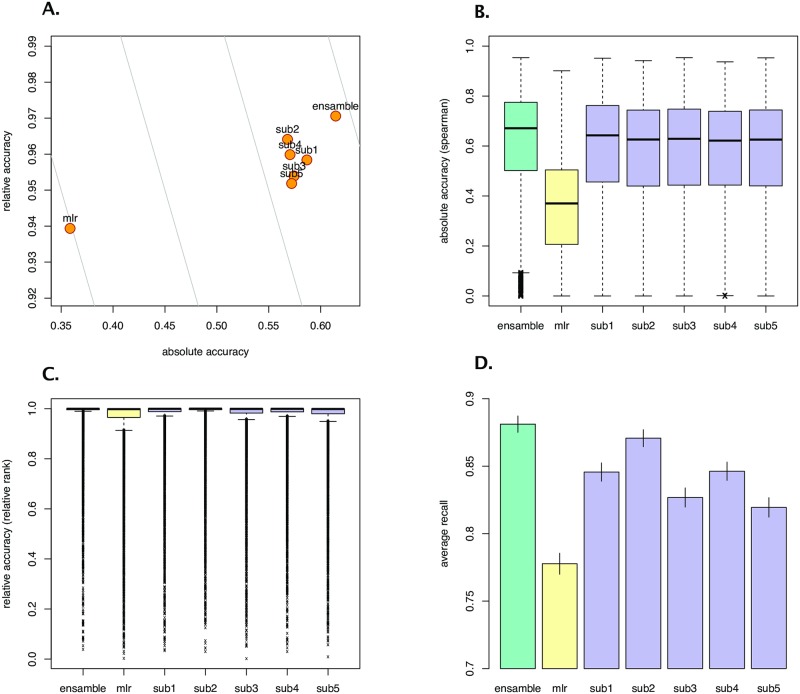
Gene inference challenge outcomes.(A): Scatter plot showing the average performance of the top 5 submissions, the benchmark, and an ensemble that takes the best-predicting algorithm from the top 5, where the performance is represented in two dimensions: absolute accuracy (gene-level Spearman correlation) and relative accuracy (gene-level relative rank); curves (light gray) represent locus of points on the plane giving the same aggregate score (curves on the right of this plot represent higher aggregate scores); (B): Boxplot showing absolute accuracy at the gene level for all the top 5 submissions, the benchmark, and the ensemble; (C): Boxplot showing relative accuracy at the gene level for all the top 5 submissions, the benchmark, and the ensemble; and (D): Recall (defined as proportion of genes with a relative accuracy below .95) for all the top 5 submissions, the benchmark, and the ensemble.